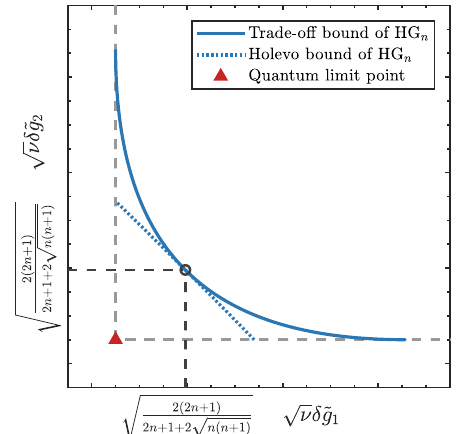
Fig. 7 | Comparison of the trade-off bound and the Holevo CR bound for two incompatible parameters g i and g j . The gray dashed lines are the QCR bounds, where the cross point (red triangle) is the corresponding QL point. The blue solid curve stands for the trade-off bound with normalized Berry curvature ~ C ij =1, and thebluedottedcurvestandsfortheHolevoboundwithnormalizedBerrycurvature ~ C ij =1. The purplesolid curve stands for the trade-offbound with normalized Berry curvature ~ C ij =0 : 8, and the purple dotted curve stands for the Holevo bound with normalized Berry curvature ~ C ij =0 : 8.